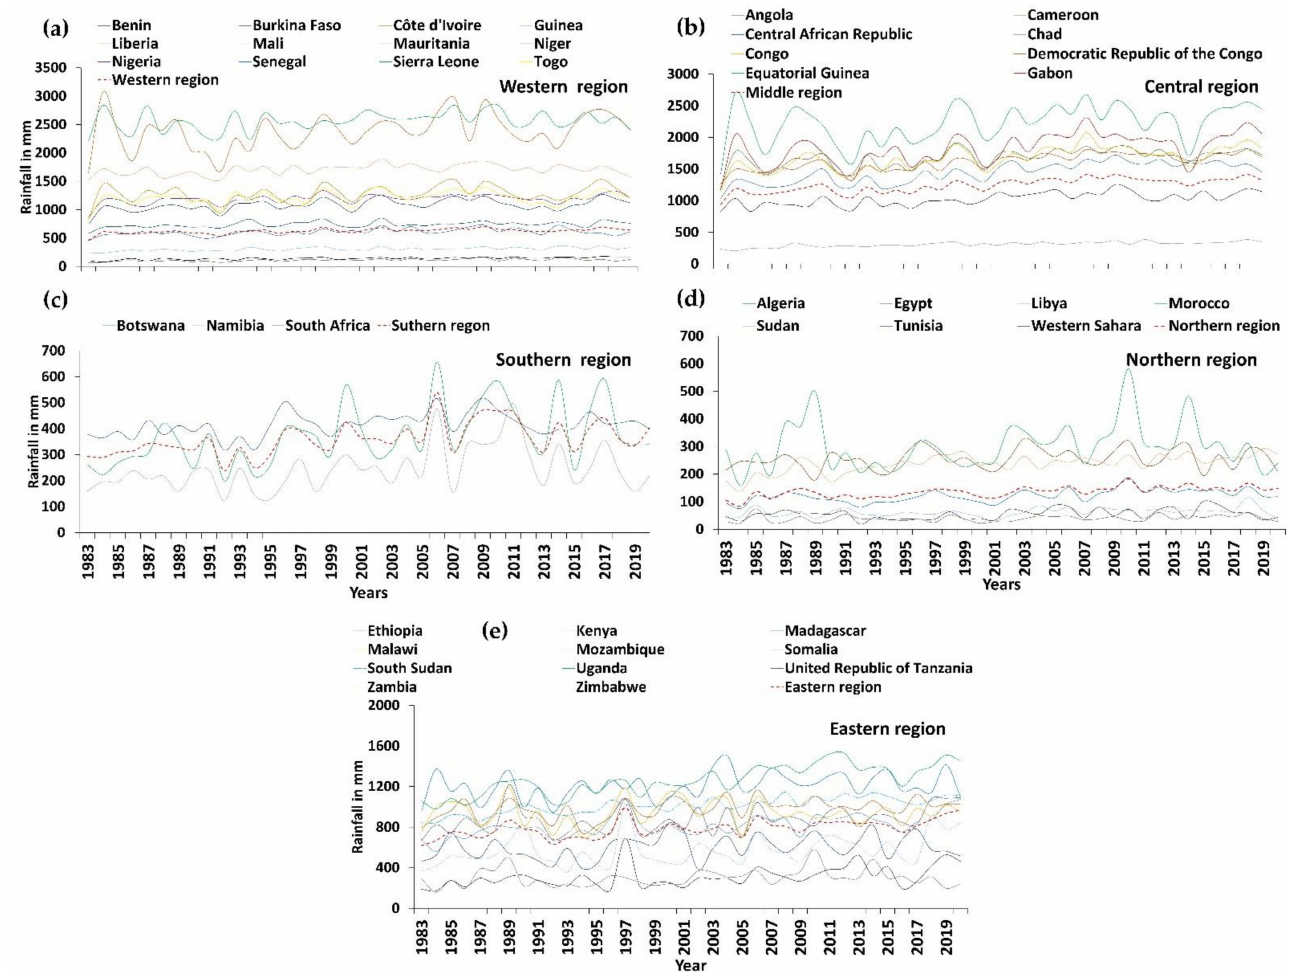
Figure 6. Time-series rainfall representation of African countries belonging to a particular region in between 1983 and 2020. ( a ) Western region, ( b ) Central region, ( c ) Southern region, ( d ) Northern region and ( e ) Eastern